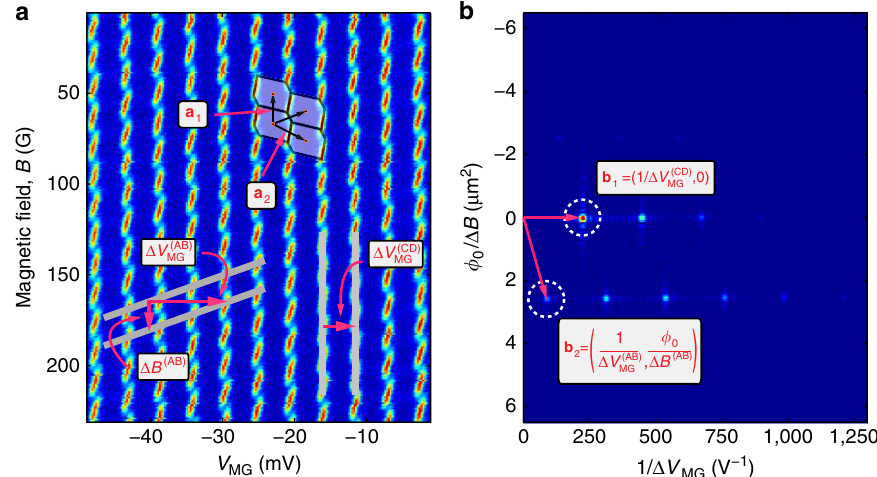
Figure 3 | Conductance of a FPI operating in an intermediate regime as a function of the modulation-gate voltage d V MG and the magnetic field d B. ( a ) 2D conductance measured with the FPI with an Ohmic contact in its vicinity (seen in Fig. 1c) at B ¼ 5T, giving rise to a charge stability diagram. The vectors marked on top of the figure connect different cell and can be translated to physical processes, as elaborated in analysis. Grey lines mark the underlying AB and CD frequencies. ( b ) 2D FFT of the conductance in a , revealing a clear lattice structure as well, as expected from an FFT of a lattice. The underlying AB and CD frequencies, marked by two vectors ( b 1 and b 2 . respectively, highlighted with white dashed circles), span this Fourier lattice, and the reason for their appearance here is elaborated in